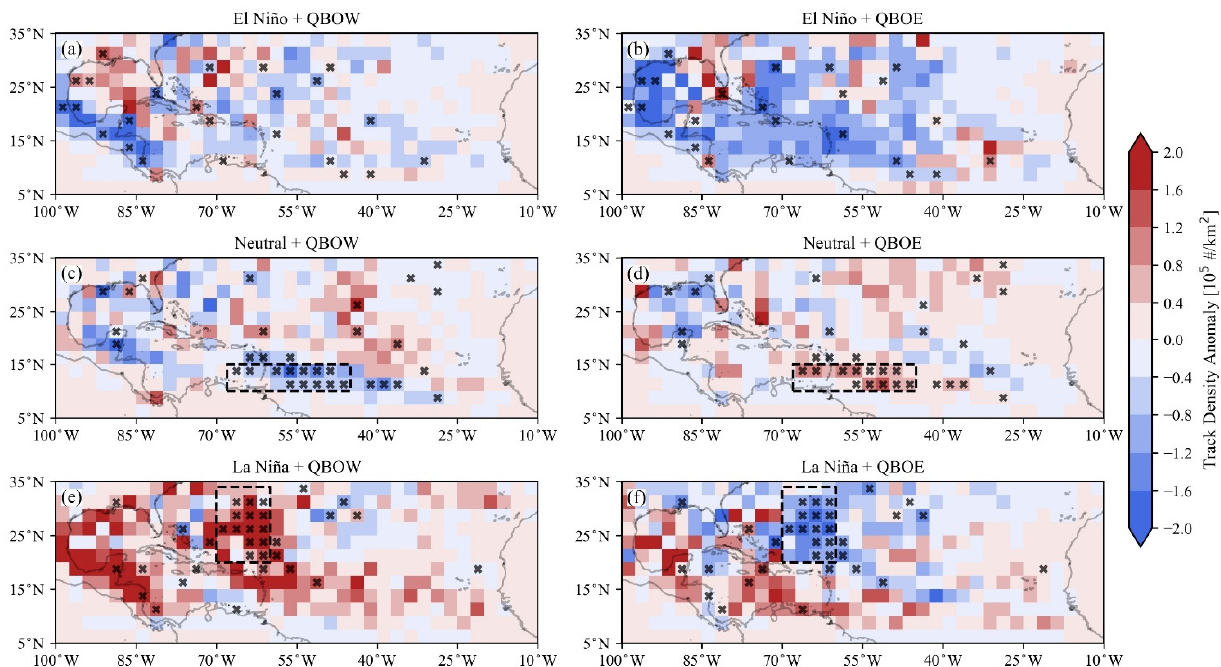
Figure 3. Mean TCs track density anomalies during the season JJASON for the years classified as ENSO and QBO phases: ( a ) El Niño-QBOW, ( b ) El Niño-QBOE, ( c ) Neutral-QBOW, ( d ) Neutral-QBOE, ( e ) La Niña-QBOW, and ( f ) La Niña-QBOE during the 1953–2020 period. The crosses show the statistically significant regions where the p -value of the Mann-Whitney U test is lower than 0.1.